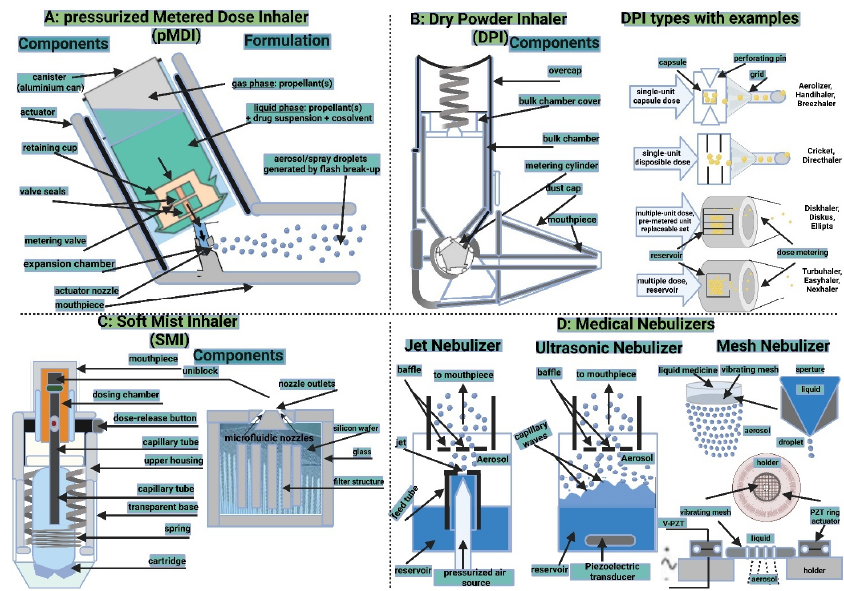
Figure 11. Schematic representation of inhalation drug delivery devices: ( A ) pressurized Metered- Dose Inhaler (pMDI). ( B ) Dry Powder Inhaler (DPI). ( C ) Soft Mist Inhaler (SMI). ( D ) Medical (jet, ultrasonic, and mesh)